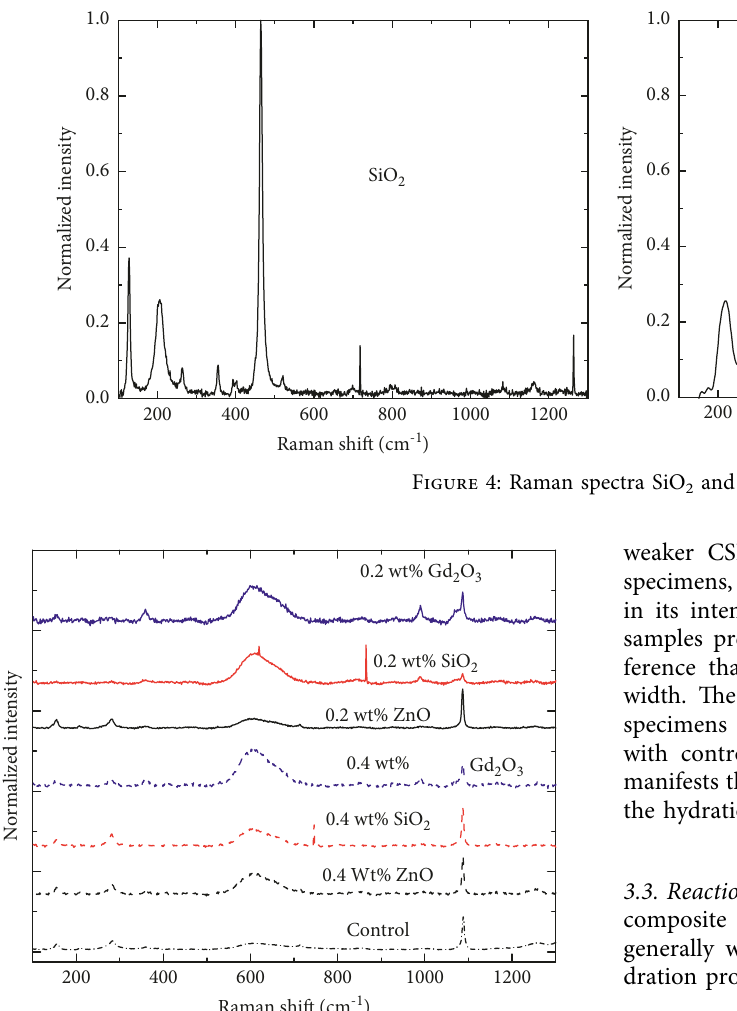
Figure 5: Raman spectra for cement paste matrices with 0.2wt% ZnO, SiO 2 , Gd 2 O 3 (solid lines) and 0.4wt% ZnO, SiO 2 , Gd 2 O 3 (dashed line) vs. the control samples (dash dot